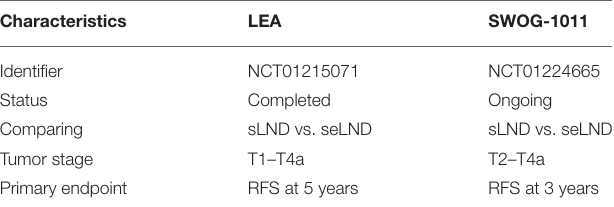
TABLE 4 | Comparison of the LEA and SWOG-1011 trial